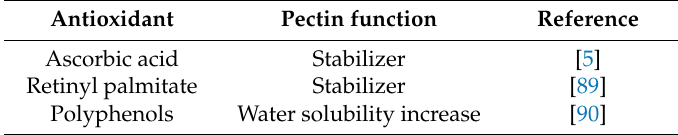
Table 2. The auxiliary function of pectin for active antioxidant